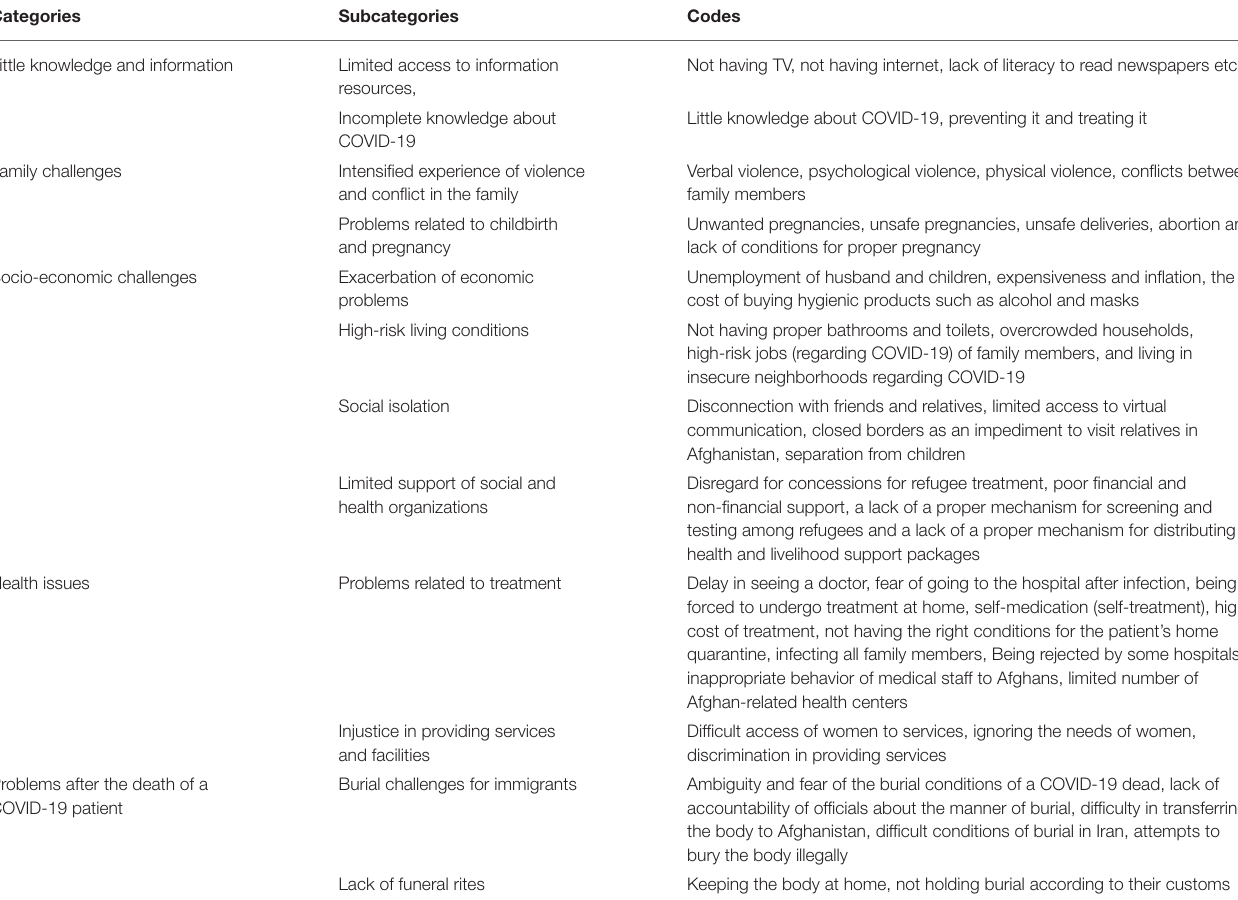
TABLE 3 | Categories, subcategories and codes obtained from interviews with Afghan women.